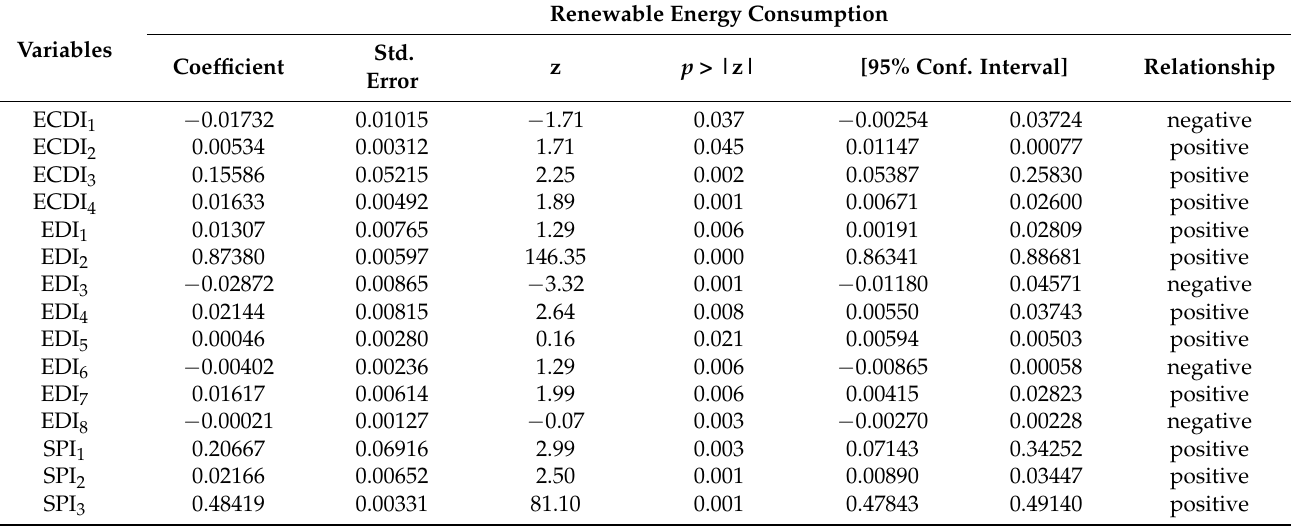
Table 3. Panel generalized method of moments